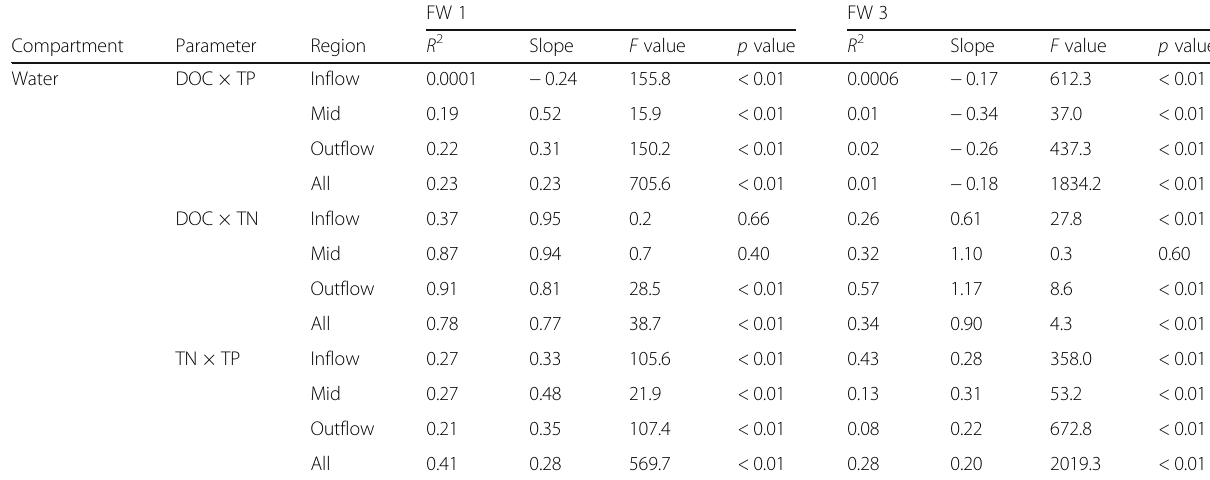
Table 2 Surface water standardized major axis regression results for flow way 1 (FW 1) and FW 3 within Stormwater Treatment Area-2 for inflow, mid, outflow, and entire FW (ALL) regions. Stoichiometric comparisons include dissolved organic carbon to total phosphorus (DOC:TP), dissolved organic carbon to total nitrogen (DOC:TN), and total nitrogen to total phosphorus (TN:TP) FW 1 FW 3